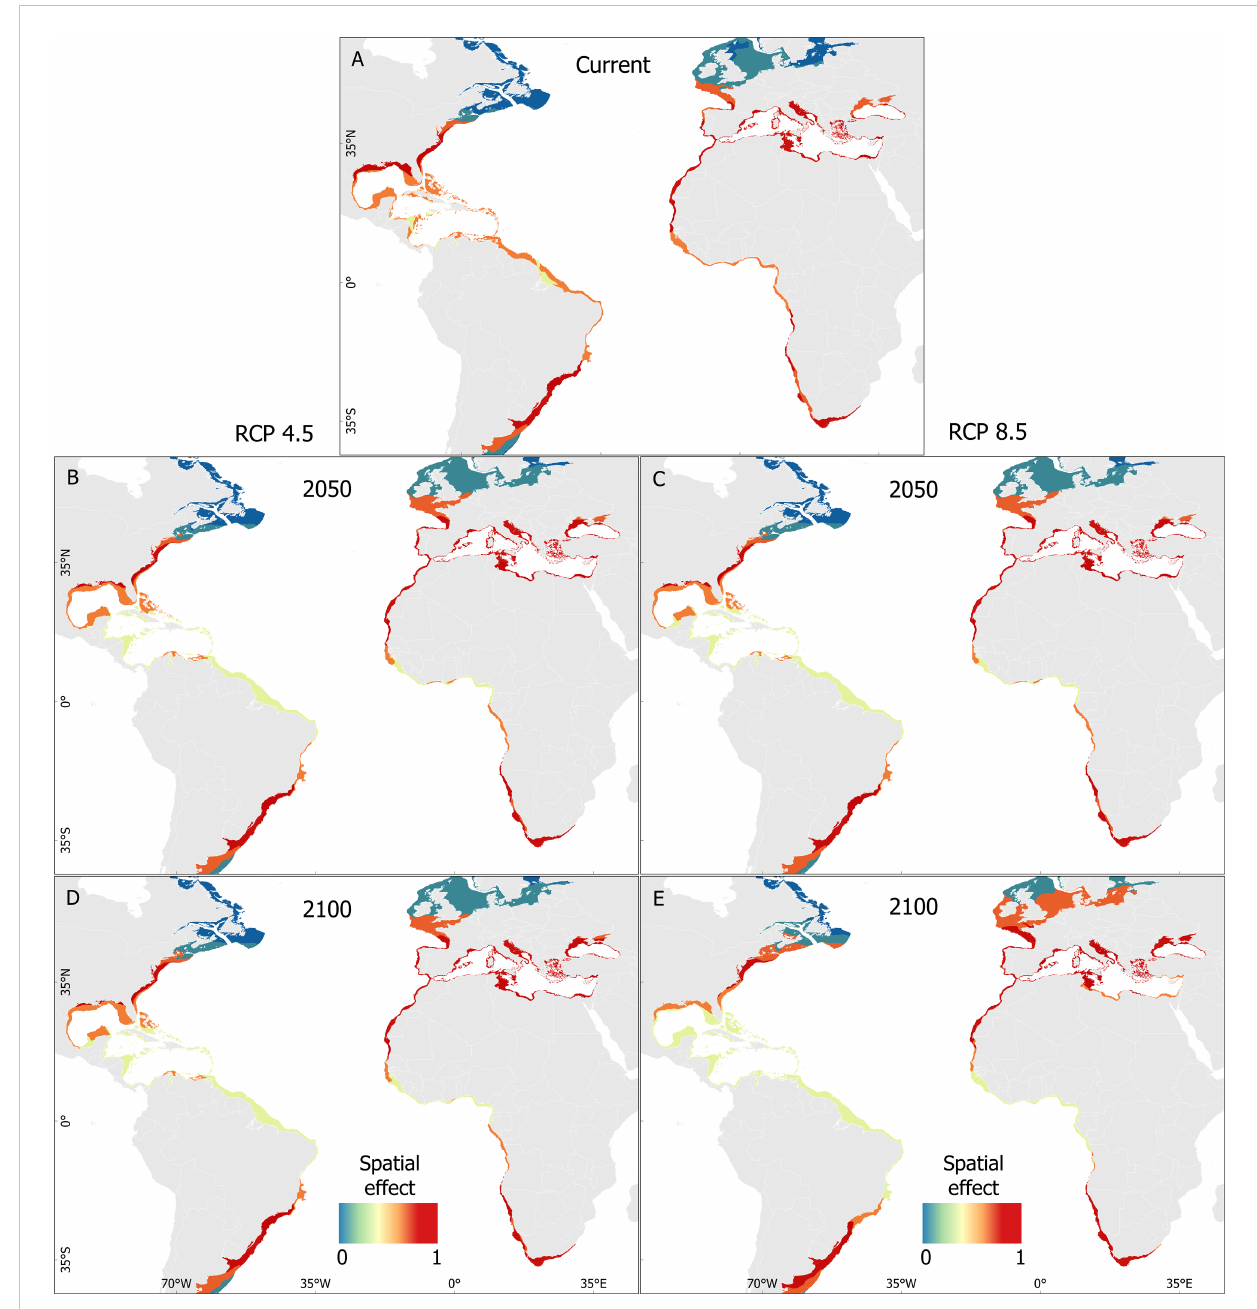
FIGURE 5 Partial spatial dependence plots for the Atlantic blue crab Callinectes sapidus Rathbun, 1896 showing the average contribution of temperature to the BART model predictions: current scenario (A) , RCP 4.5 2050 (B) , RCP 8.5 2050 (C) , RCP 4.5 2100 (D) , and RCP 8.5 2100 (E)